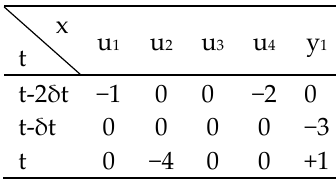
Figure 2. Example of a mask in FIR methodology.